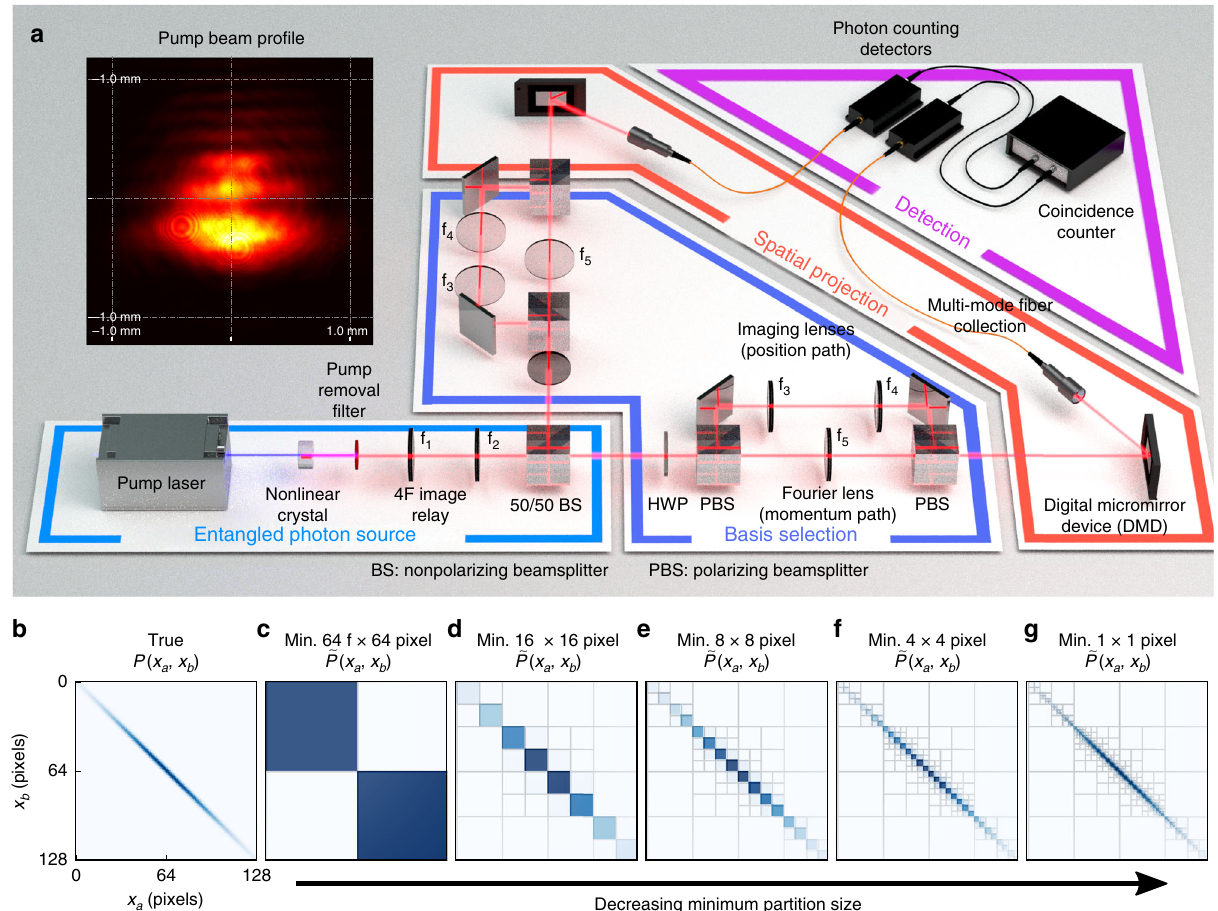
Fig. 1 Experimental set-up for adaptive measurements. a An entangled photon source produces spatially entangled photon pairs, which are separated and routed through basis selection optics that switch between measuring transverse-position or transverse-momentum. Computer-controlled digital micromirror devices and photon-counting detectors perform joint spatial projections at up to 512 × 512 pixel resolution. b shows a simulated, true position joint-distribution of P ( X a , X b ) at 128 × 128 pixel resolution, while c – g show its simulated, adaptively decomposed estimate ~ P ð X detail via quad-tree decomposition. When the joint-intensity in a block exceeds a user-de fi ned threshold, it is split into four sub-quadrants and the process is recursively repeated, rapidly partitioning the space to obtain a compressed distribution from very few